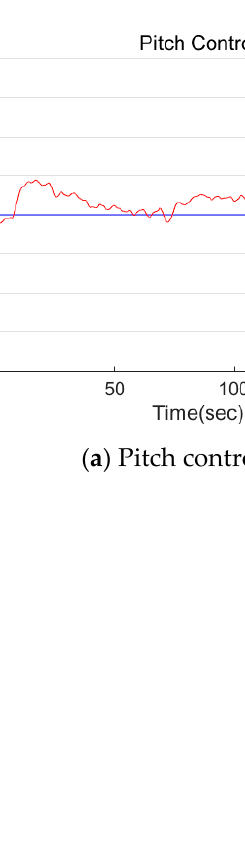
Figure 9. TUP experiment result in water tank (1 knot).